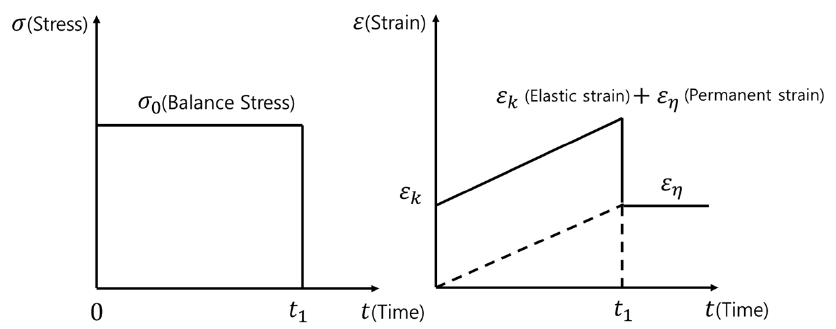
Figure 10. Free end displacement changes in time domain due to viscoelasticity.